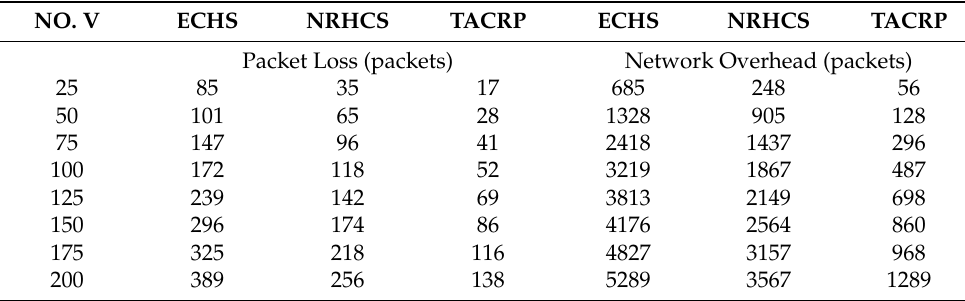
Table 4. Overall Performance Value Analysis-According to number of